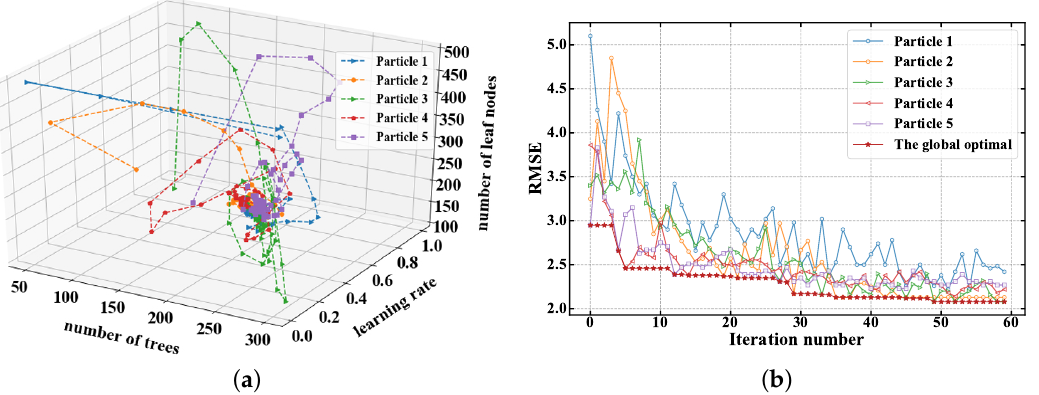
Figure 7. The iterative optimization process of the PSO-GBDT model: ( a ) The trajectories of the five particles. ( b ) RMSE results of the 5-fold cross validation experiment.